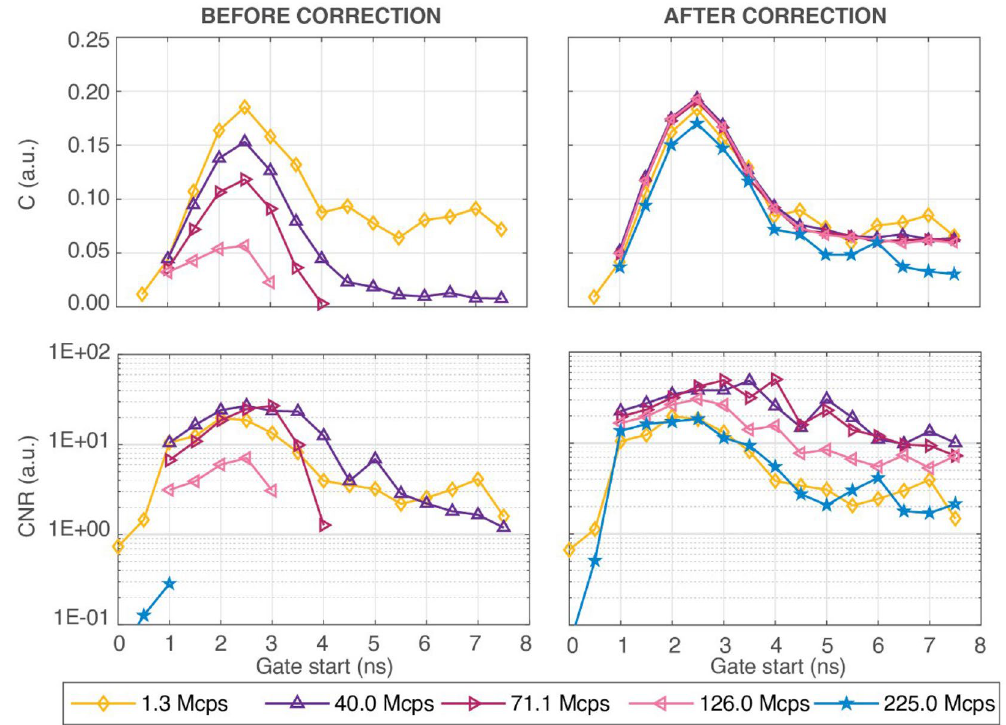
Figure 4. nEUROPt protocol results for experimental data. Contrast (first row) and CNR (second row) values are shown at subsequent gates (evaluated from the IRF peak) for different CRs (colours and marker types). For both FOMs, results before (left plots) and after (right plots) pile-up correction are